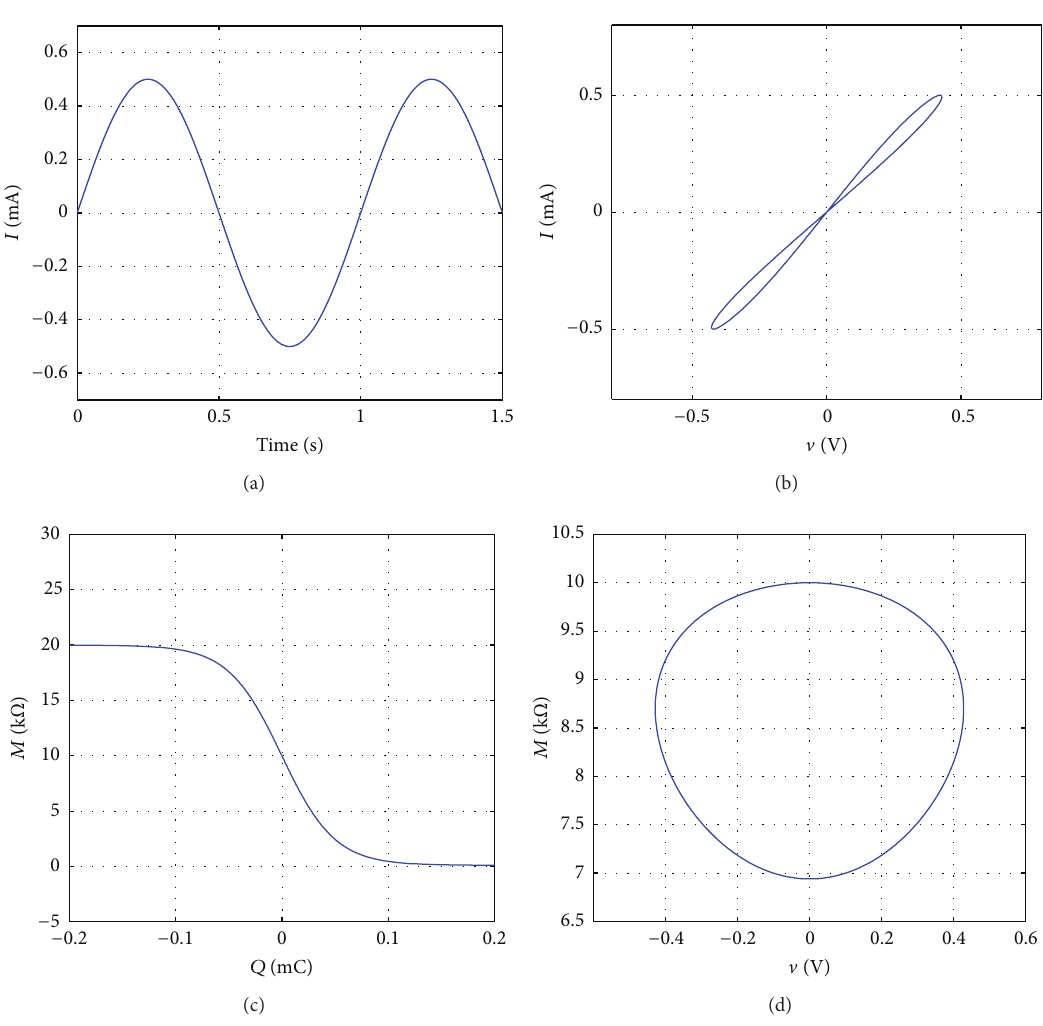
Figure 5: The results of the memristor Simulink model. (a) The input current source. (b) Relationship between the current 𝑖 and the voltage V . (c) Relationship between the memristance 𝑀 and the charge 𝑞 . (d) Relationship between the memristance 𝑀 and the voltage V .